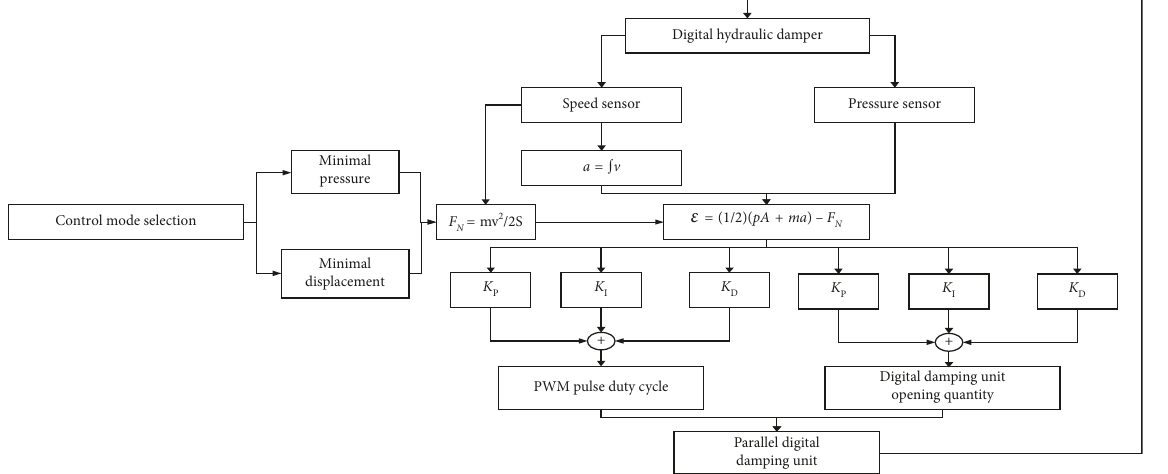
Figure 36: Control model of the energy dissipation